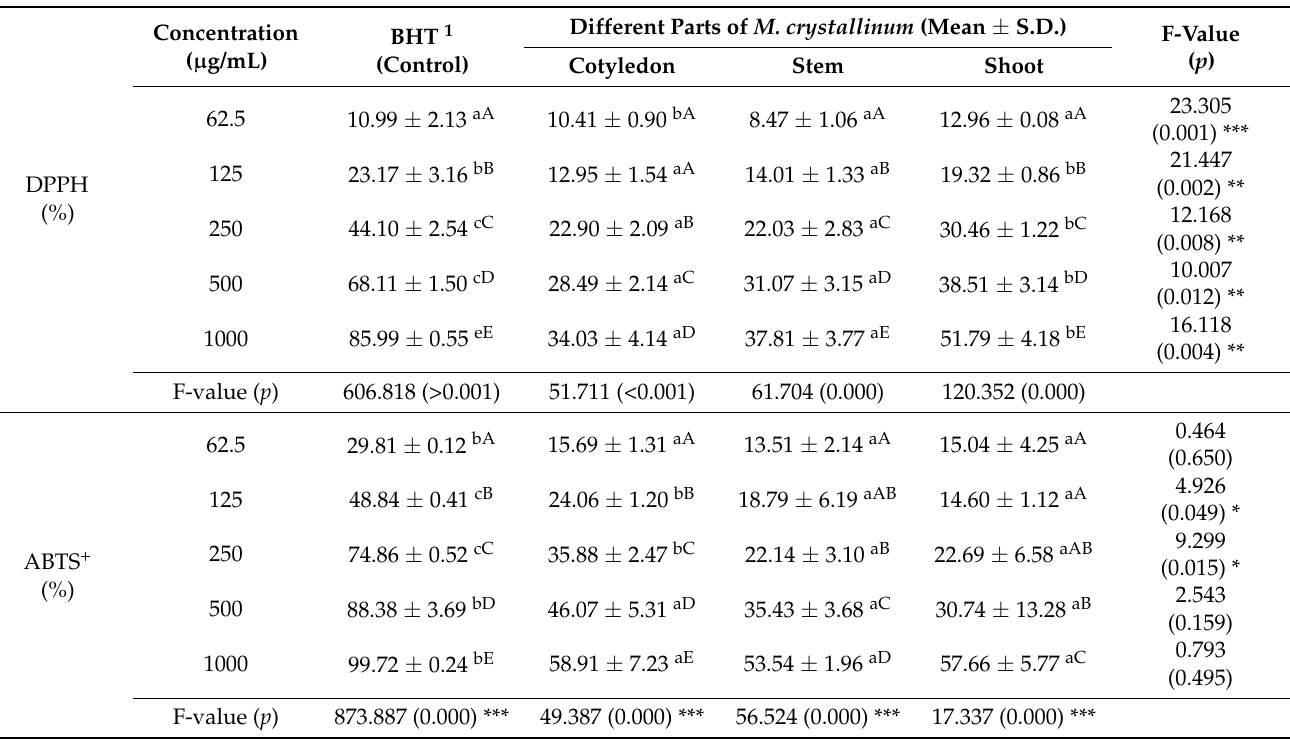
Table 2. DPPH and ABTS + radical scavenging activities with mean ± S.D. (%), ranging from 62.5 µ g/mL to 1000 µ g/mL of ethanol extract from the cotyledon, stem, and leaves of ice plant ( M. crystallinum